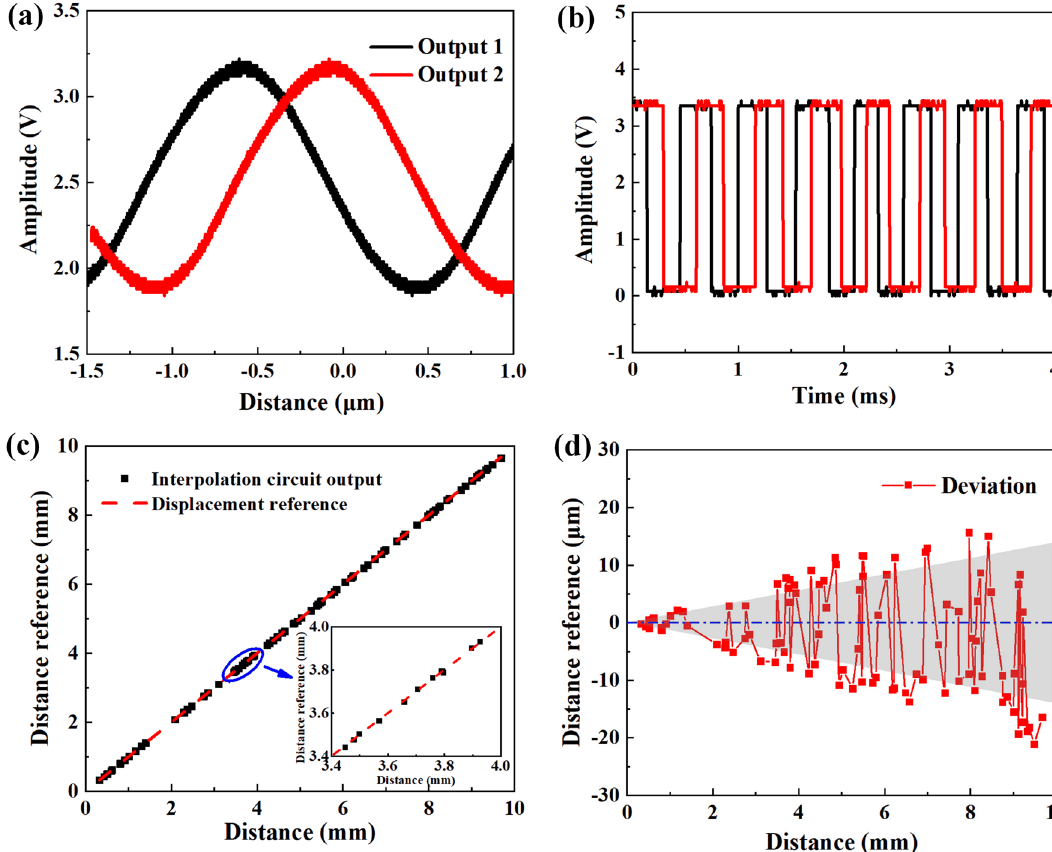
Figure 9. ( a ) Two sinusoidal signals with quadrature phase shift. ( b ) Standard incremental AB quadrature digital signal. ( c ) Comparison of the linear encoder positioning system and displacement output of the interpolation circuit. ( d ) Error distribution